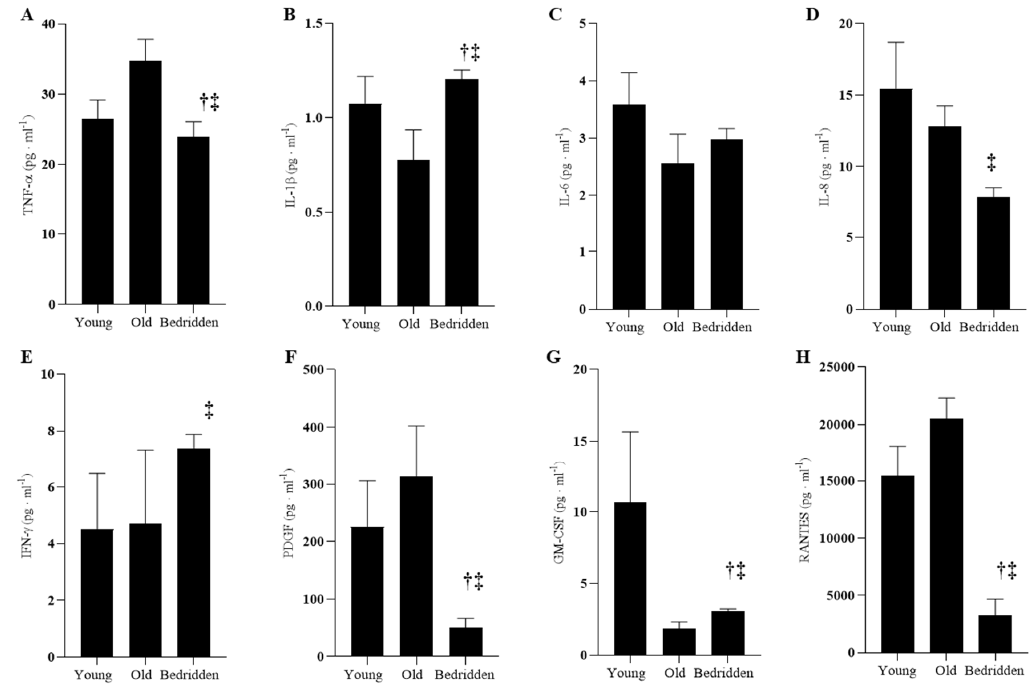
Figure 2. Inflammatory profile and comparison between groups: Young, Old, and Bedridden. Data are presented as mean and standard deviation. Kruskal–Wallis one-way analysis of variance on ranks was used to identify between groups di ff erences. Tumor necrosis factor- α (TNF- α , panel A ); interleukin-1 β (IL-1 β , panel B ); interleukin-6 (IL-6, panel C ); interleukin-8 (IL-8, panel D ); interferon- γ (IFN- γ , panel E ); platelet-derived growth factor (PDGF, panel F ); granulocyte-macrophage colony stimulating factor (GM-CSF, panel G ), regulated on activation, normal T cells expressed and secreted (RANTES, panel H ). † Between-groups di ff erence versus the Young group ( p < 0.05). ‡ Between-groups di ff erence versus the Old group ( p < 0.05).